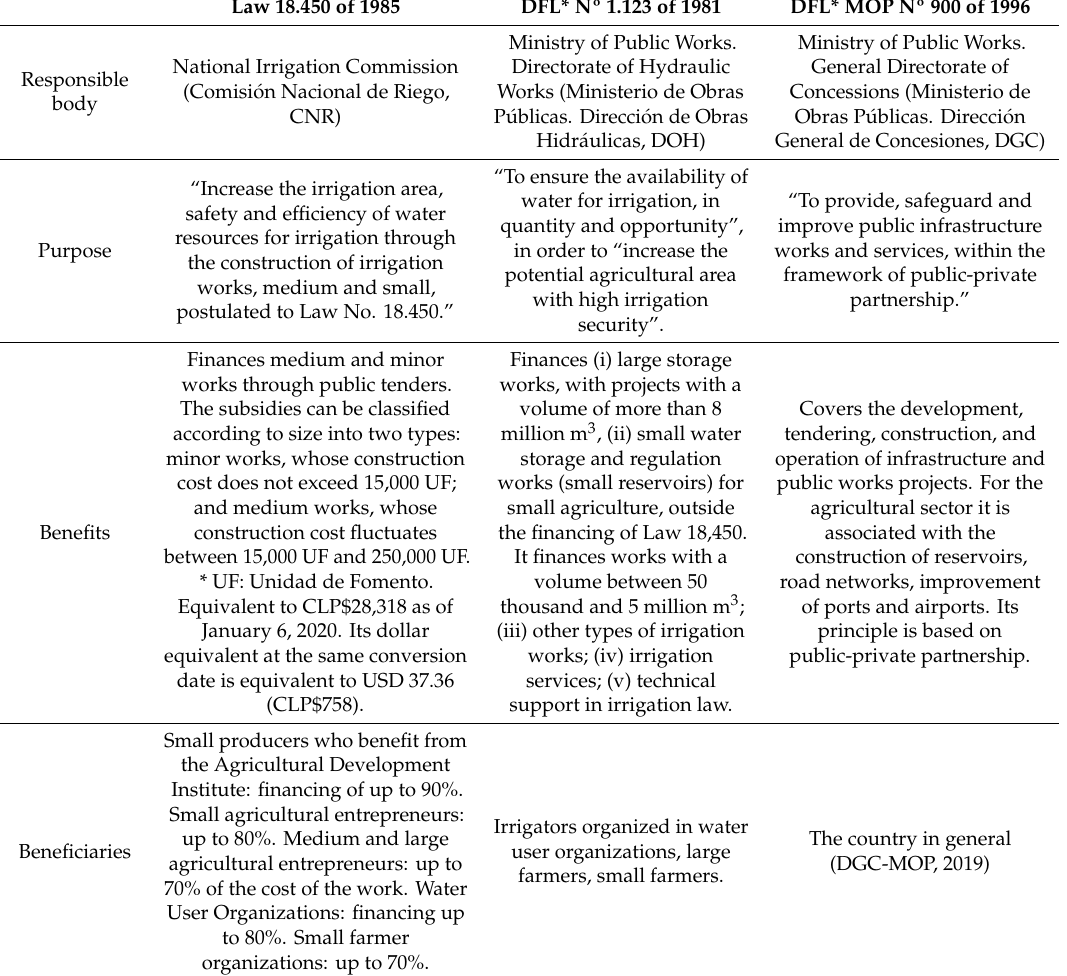
Table 3. Comparison of subsidiary instruments facilitating agribusiness